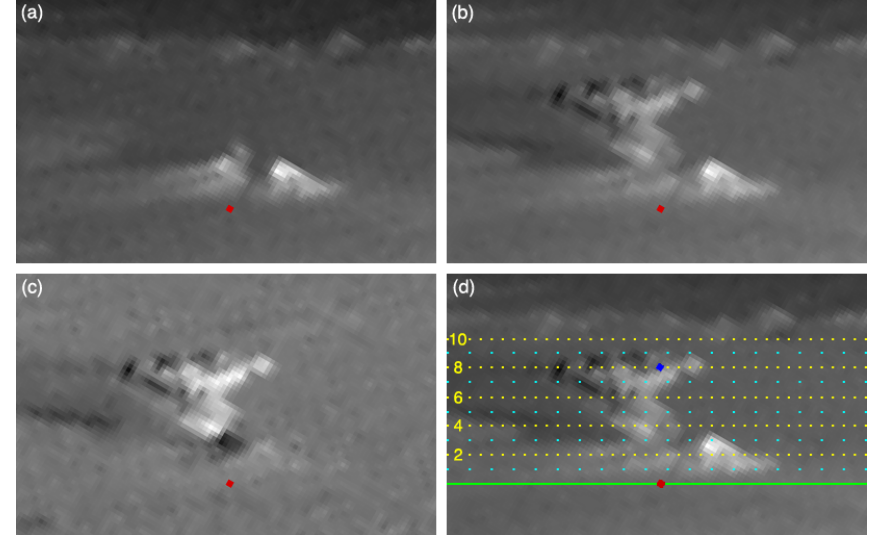
Figure 10. GOES-17 band 2 fixed grid image (8 × magnification) of Young and Old Sheveluch (2589 and 3307m, respectively) on 8 April 2020 at (a) 19:00UTC, (b) 19:10UTC, and (c) 19:10UTC running-difference image, as well as (d) 19:10UTC with base-relative isoheight lines drawn at 1km intervals. The images were rotated clockwise by the geodetic colatitude angle. The red diamond marks the base of the active Young Sheveluch, and the blue diamond indicates our best visual estimate plume top position above the